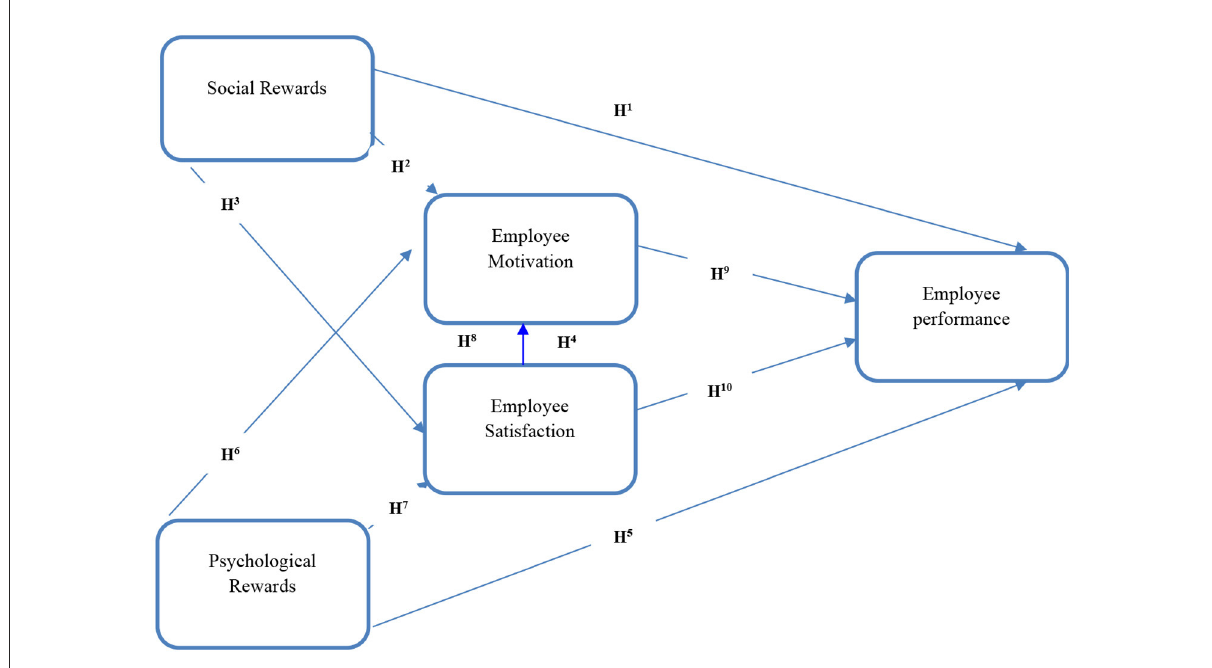
FIGURE1 Theoretical